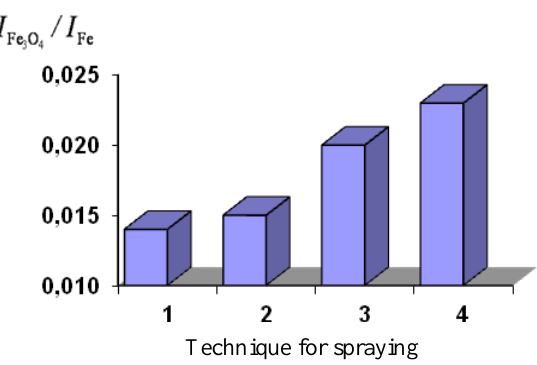
m 3 /min (2) mode 3.